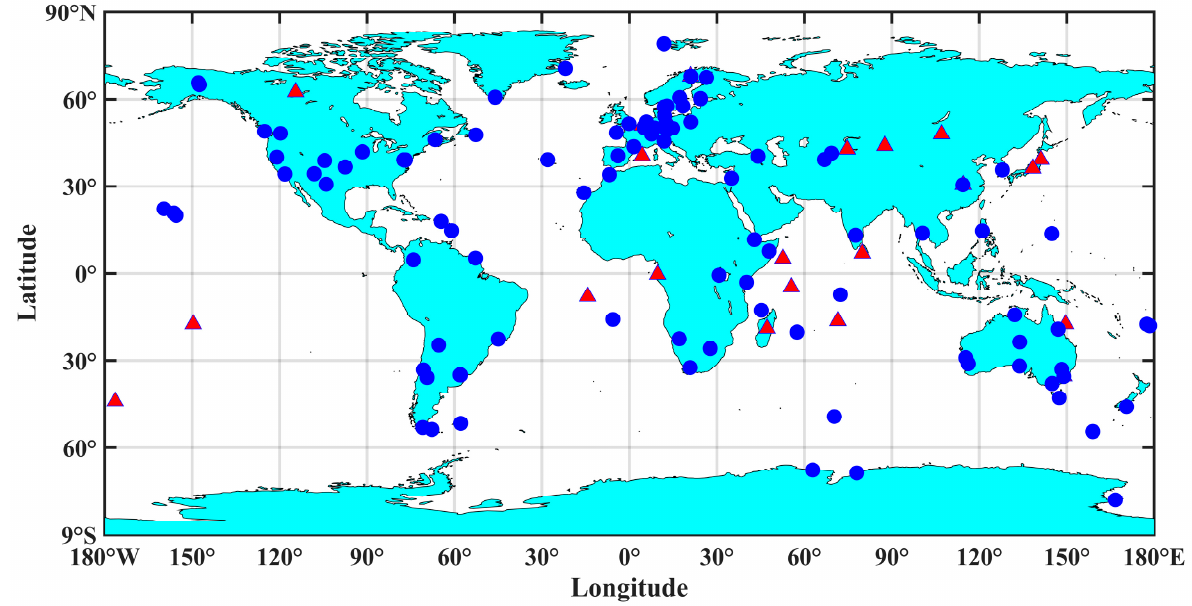
Figure 2. Distribution of MGEX stations used for the server-end OSB estimation and user-end PPP-AR verification. Blue dots denote the reference stations used in the OSB estimation; red triangular dots denote the reference stations used for the PPP-AR verification at the user end. Table 1. The PPP solution strategy and frequency parameters for each system.